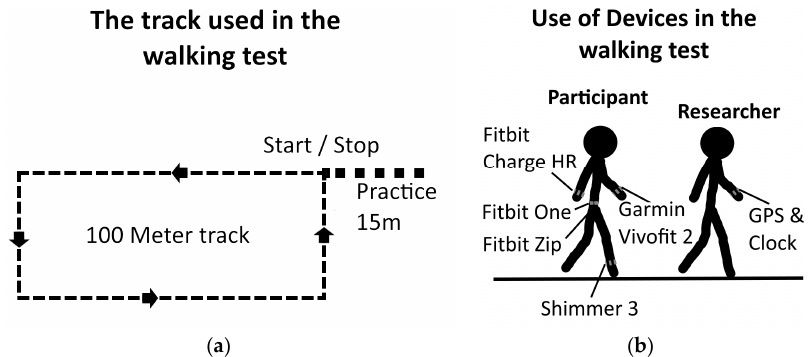
Figure 1. The two figures illustrate the setup used in the walking tests. ( a ) A drawing of the track